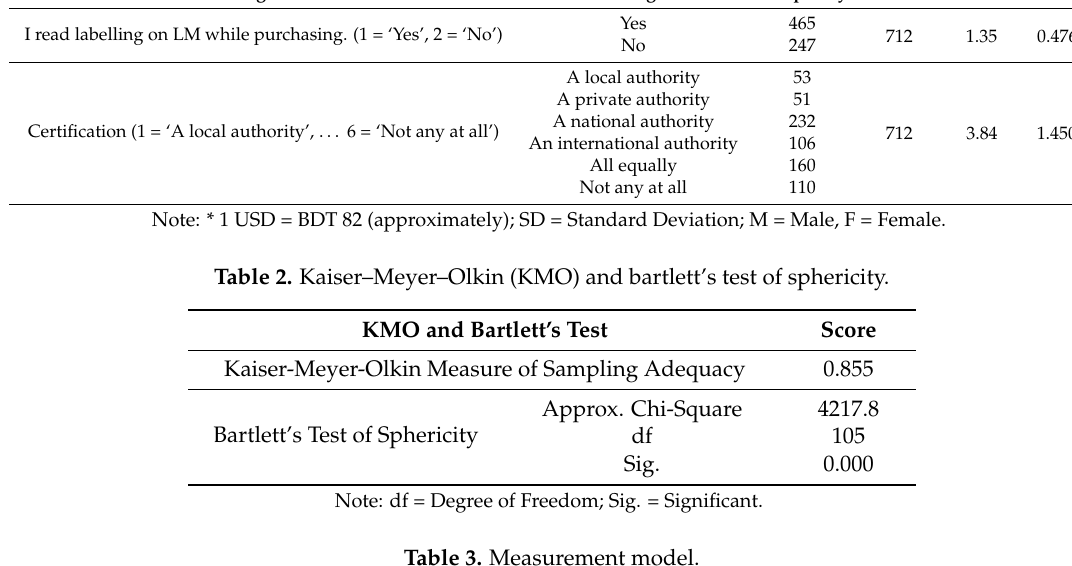
Table 3. Measurement model.